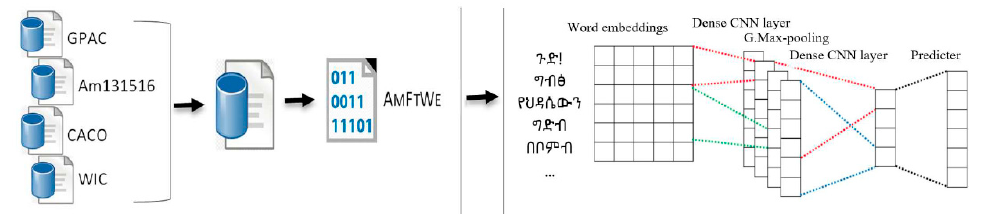
Figure 1. General diagram for the Amharic fake news detection model.